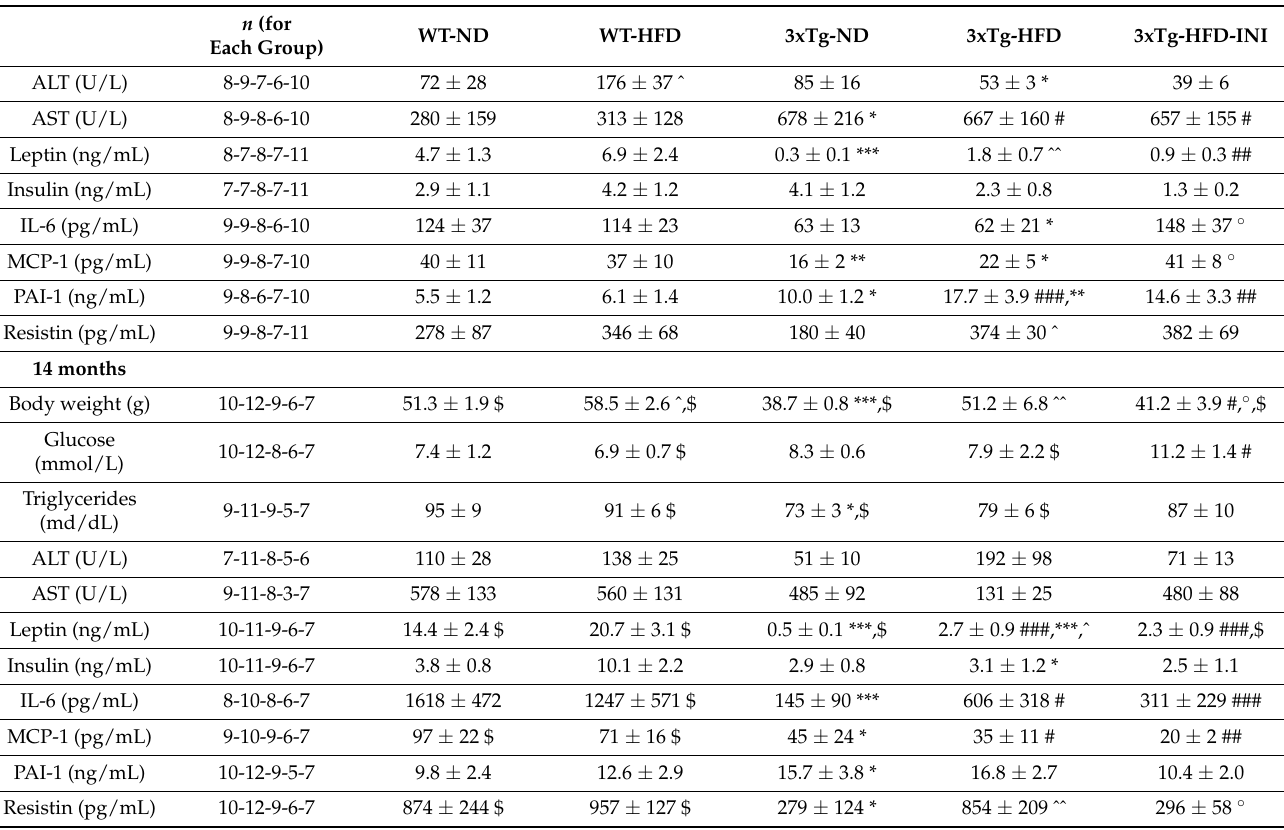
Legend: different symbols are used for each within-age comparison, * p ≤ 0.05 vs. WT, ** p ≤ 0.01 vs. WT, *** p ≤ 0.001 vs. WT, ˆ p ≤ 0.05 vs. ND, ˆˆ p ≤ 0.01 vs. ND, ˆˆˆ p ≤ 0.001 vs. ND, # p ≤ 0.05 vs. WT-ND, ## p ≤